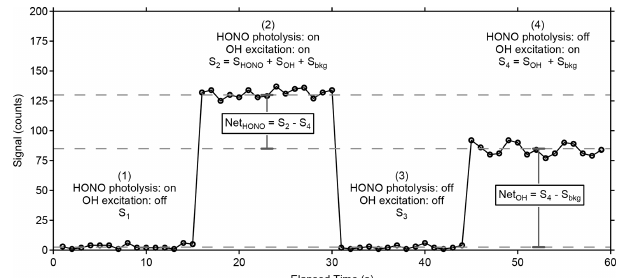
Figure 4. Sample measurement cycle from the LP/LIF instrument during measurement of OH and HONO during laboratory calibra- tions. The raw signal has not been normalized for the power of the excitation laser or the total radical concentration produced by the calibrator. S bkg is the average of the offline signals S 1 and S 3